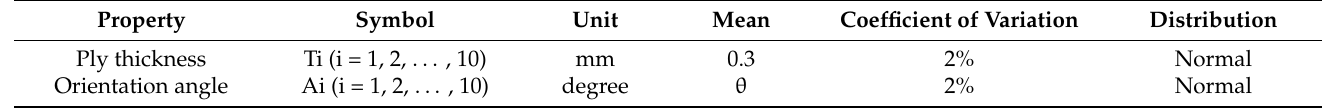
Table 2. Statistical information of the geometrical dimensions of the composite cylindrical shell.